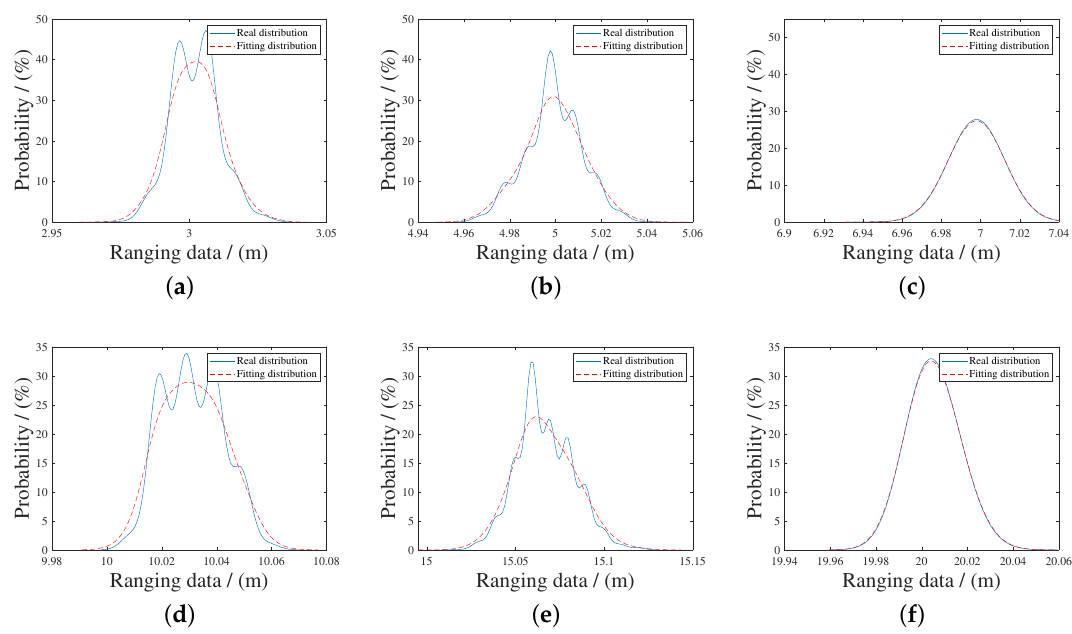
Figure 7. The probability of corrected ranging measurements is shown when distances are ( a ) 3 m, ( b ) 5 m, ( c ) 7 m, ( d ) 10 m, ( e ) 15 m, ( f ) 20 m. At every experiment, the probability distribution is approximately Gaussian distribution, and there is a smaller deviation between the maximum probability value and the true value, shown in Table 2.